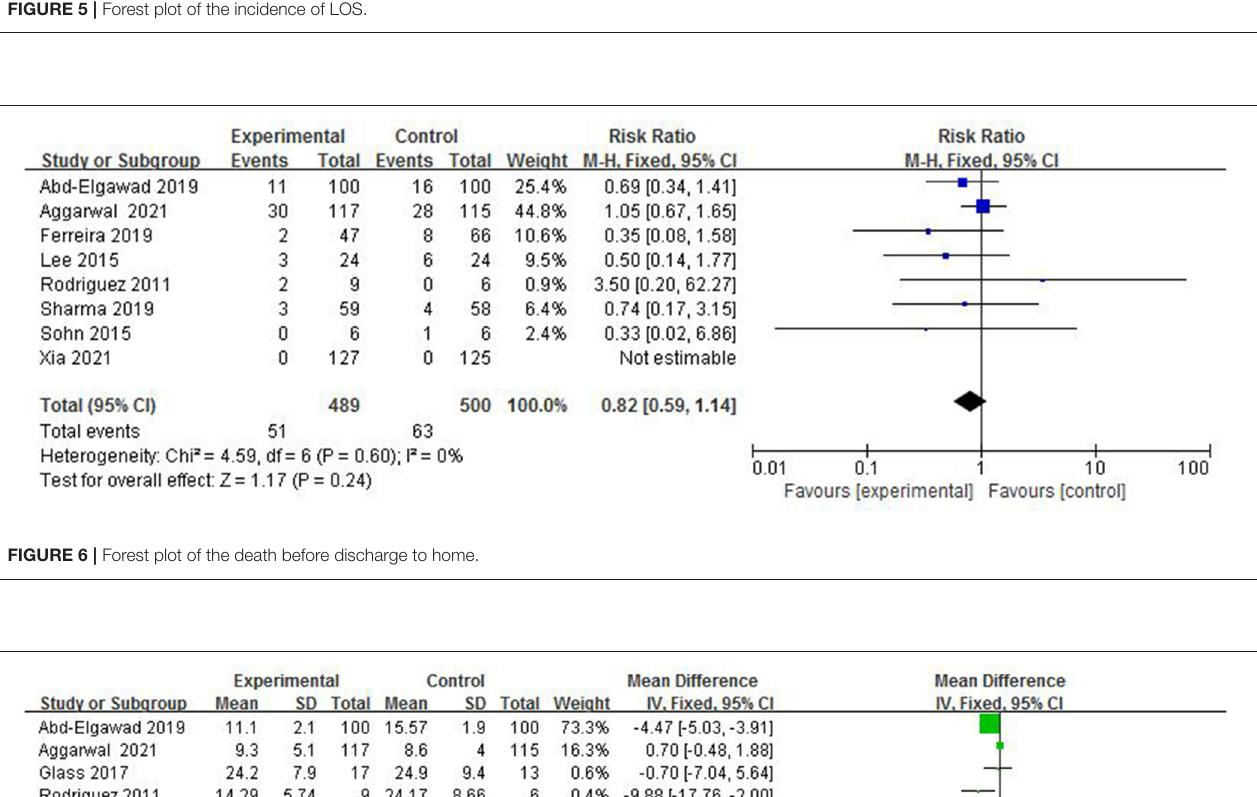
FIGURE 5 | Forest plot of the incidence of LOS.